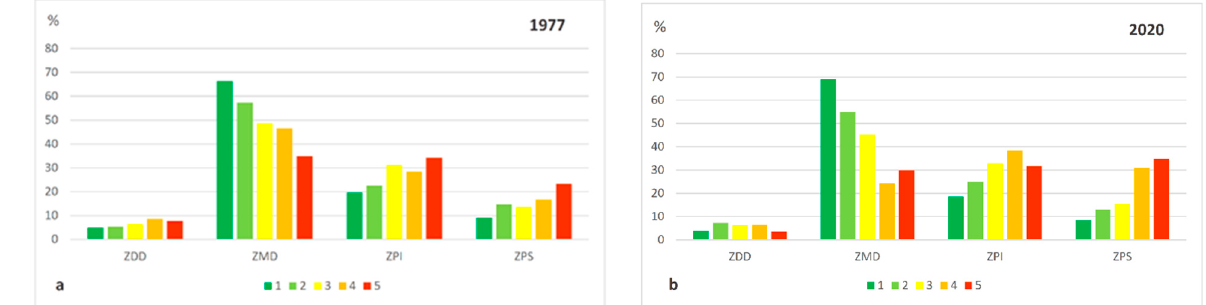
Figure 9. Proportion of fragmentation class per type of protection zone (per cent from class total): ZDD, Sustainable Development Zone; ZMD, Sustainable Management Zone; ZPI, Integral Protection Zone; ZPS, Strict Protection Zone; ( a ) 1977; ( b ) 2020.